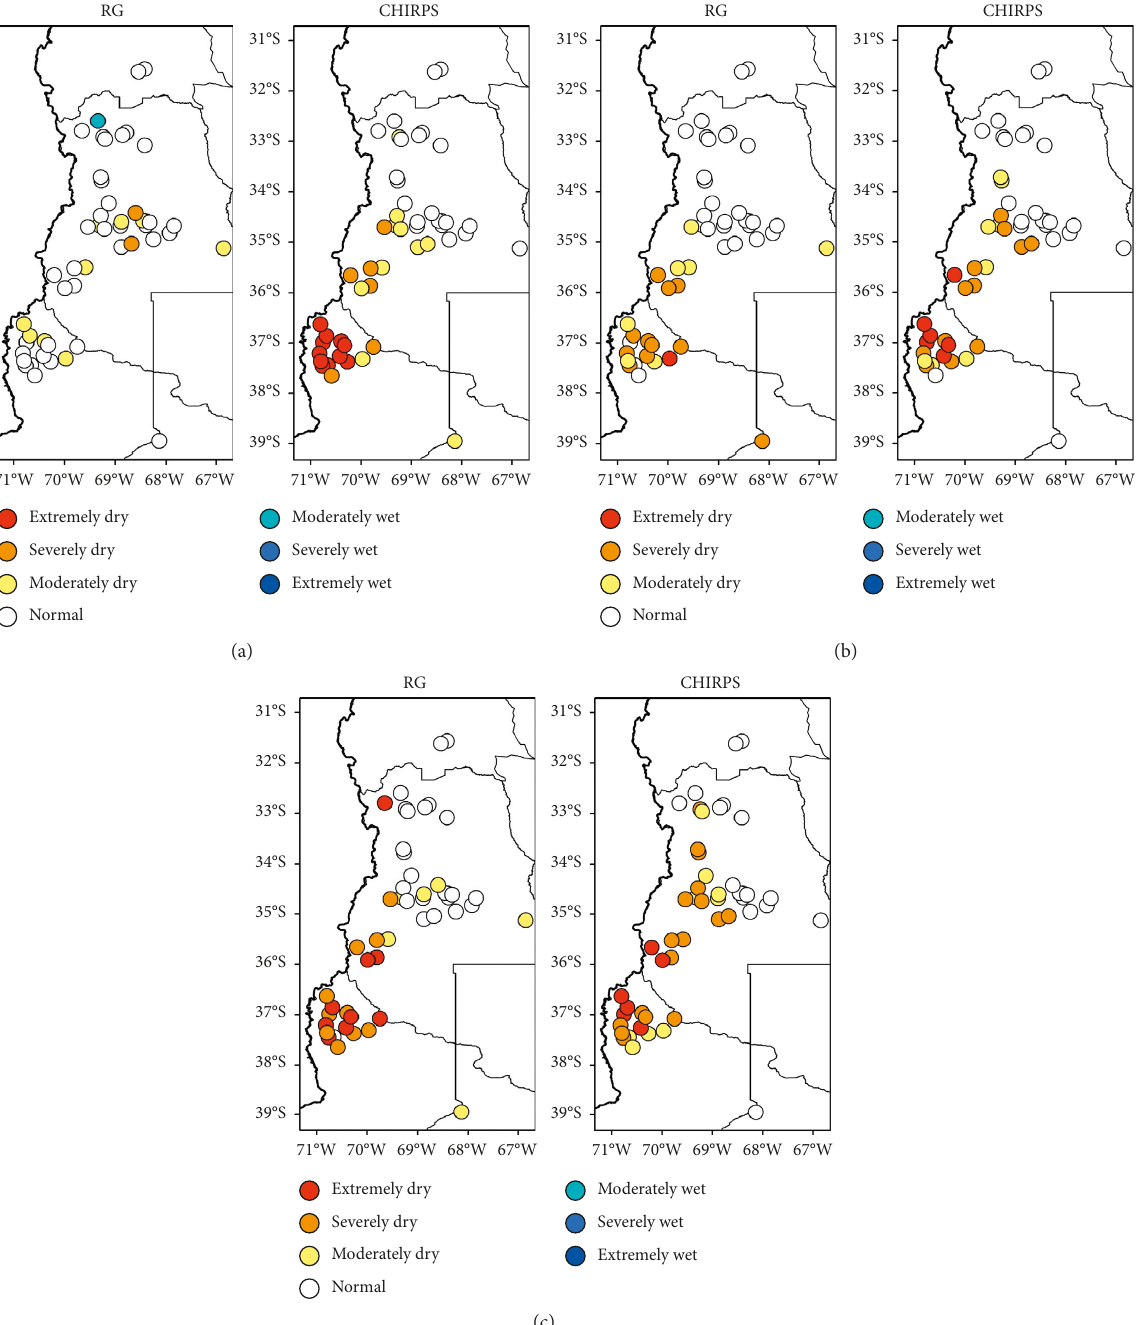
Figure 10: Spatial distribution of the SPI categories for timescales of (a) 1 month, (b) 3 months, and (c) 6 months during October 1998 considering rain gauges (RG) and CHIRPS